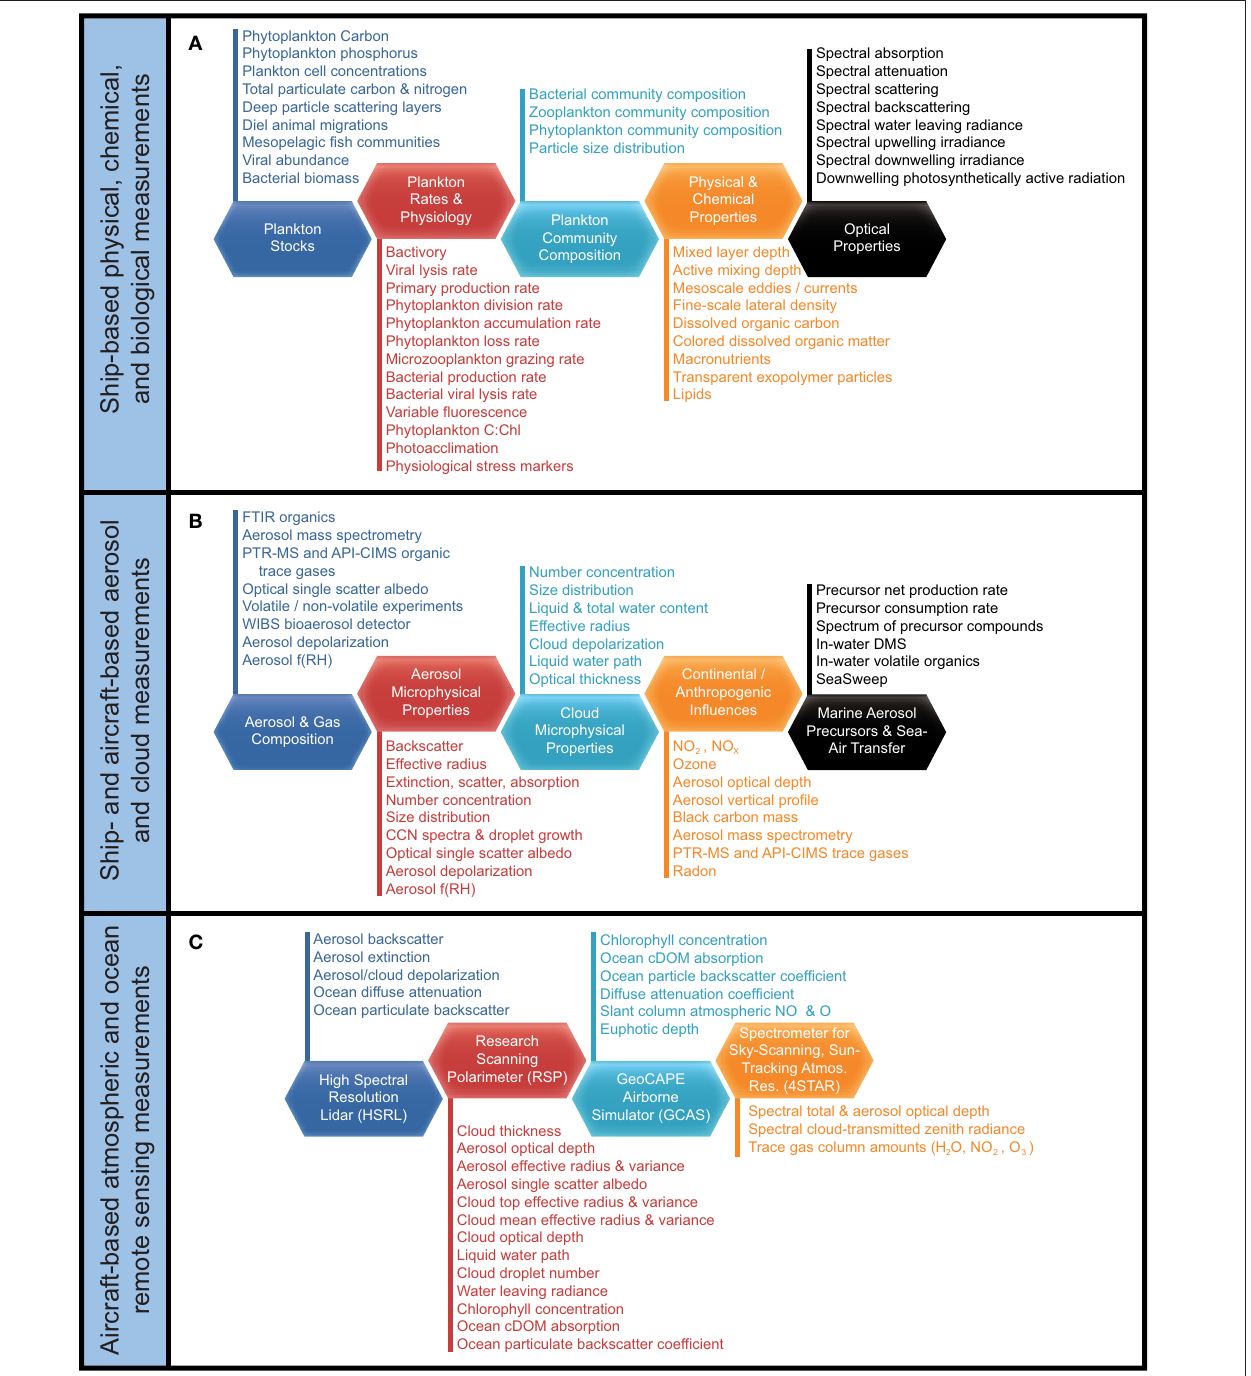
instrument intercomparisons). Upon reaching the ship, the aircraft completed a series of vertically stacked legs of ∼ 40– 80 km length designed to capture below-, in-, and